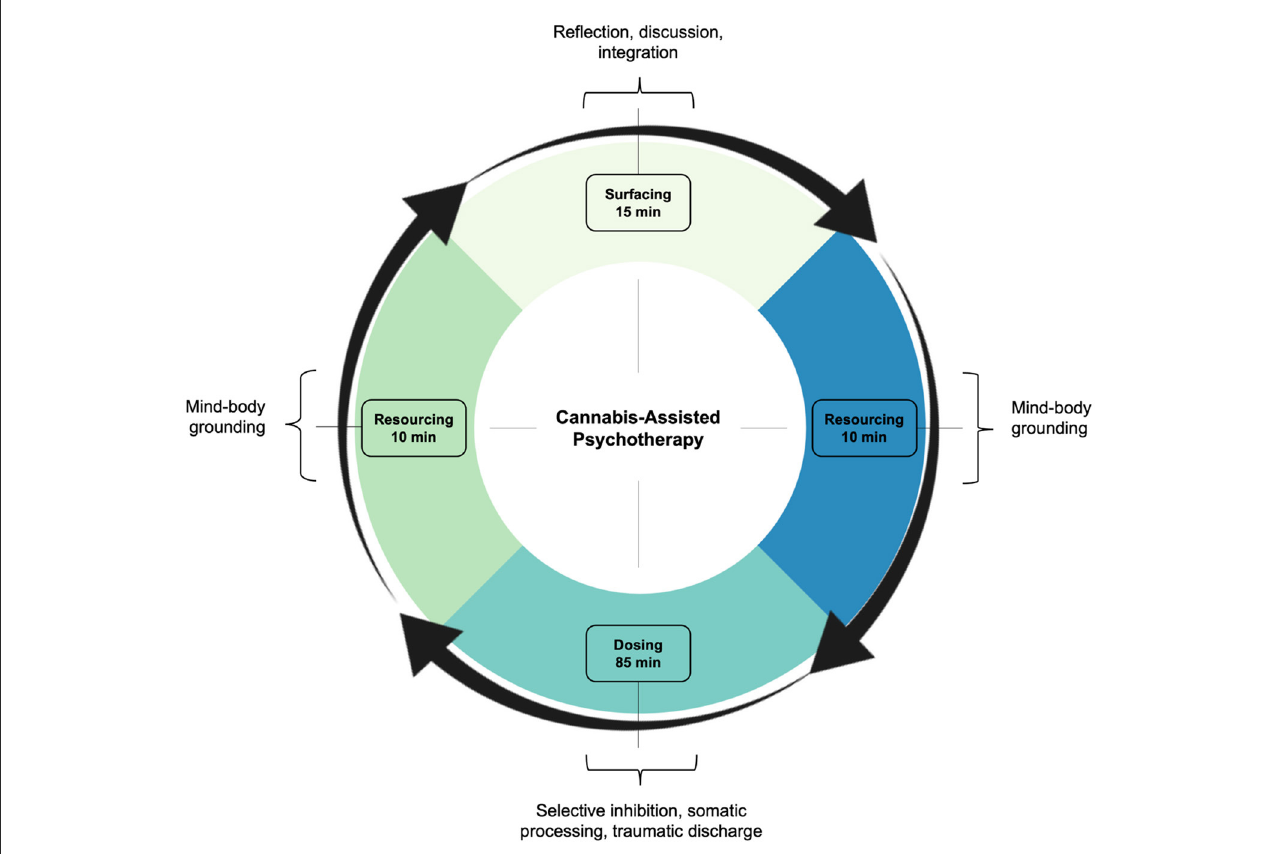
FIGURE2 Treatment framework. In line with the PSIP model, CAP involved three criteria: surfacing, resourcing, and dosing. Surfacing readied the patient for treatment, integrating experiences from prior sessions, excluding the first one. Resourcing grounded the patient before and after treatment, comprising mindfulness and nervous system regulation. Dosing included cannabis and psychotherapy, as an interactive treatment, targeting dissociative symptoms and interpersonal trauma. CAP, cannabis-assisted psychotherapy; PSIP, psychedelic somatic interactional